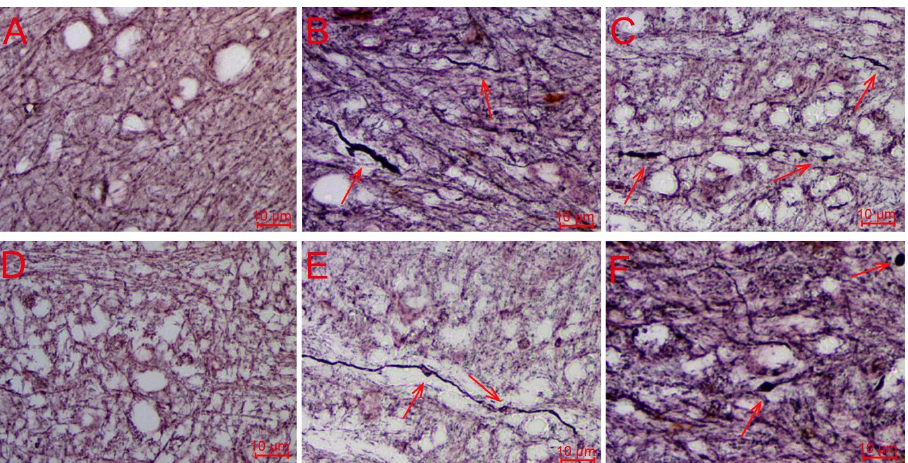
Figure 1. Histopathological examination of the brain tissue samples (200×). ( A , D ) control group; ( B , E ) 1 day group; ( C , F ) 3 day group. The axons in corpus callosum ( A – C ) and internal capsule ( D – F ) of brain samples from the injured rats demonstrated various degrees of swellings, disconnection, and axonal retraction balls (ARBs), while the control animals demonstrated no pathologic abnormalities of any kind.